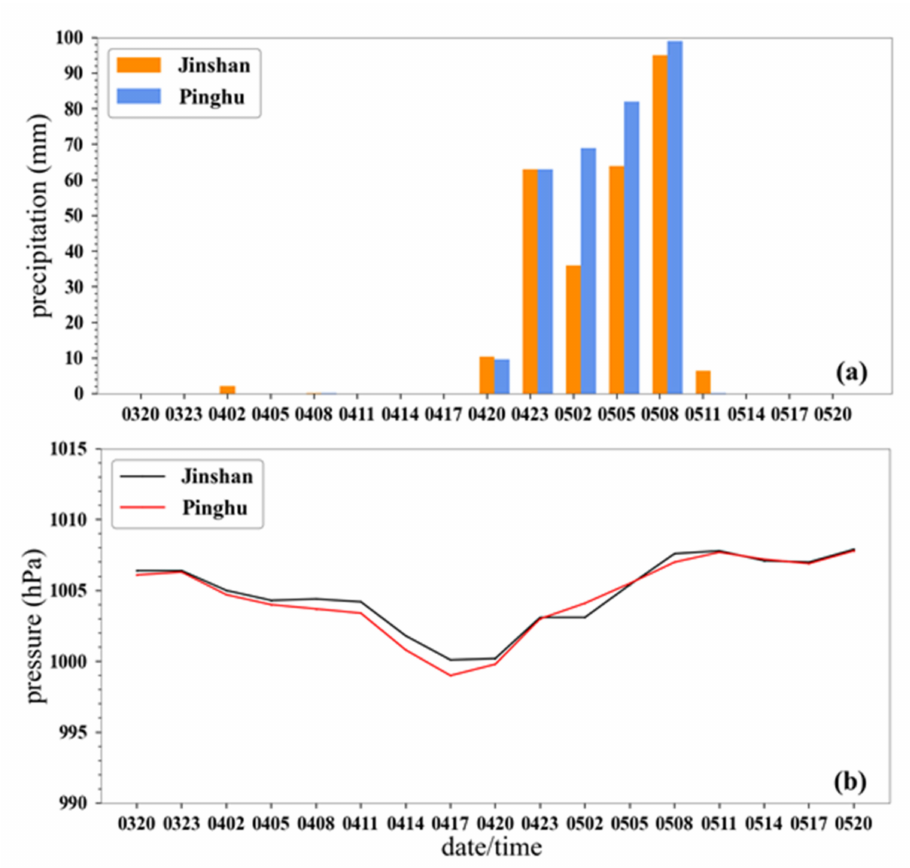
Figure 2. 3-h rainfall ( a , column, unit: mm), sea level pressure ( b , line, unit: hPa) at Jinshan Station in Shanghai and Pinghu Station in Zhejiang Province from 20:00 BT 3 to 20:00 BT 5 August